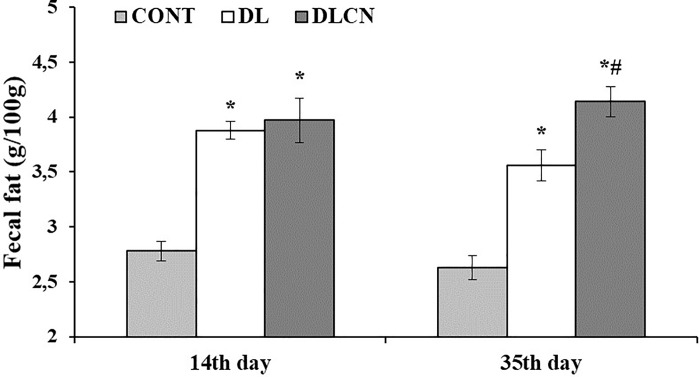
Fecal fat of rats treated with a high-fat diet with cashew nut.Rats were divided into the following groups: Control group (CONT), Dyslipidaemic group (DL) and Dyslipidemic Cashew Nut group (DLCN). The first collection occurred at 14th day of the experiment and the second collection at 35th day of experiment. * versus CONT. # versus DL, with p < 0.05, determined by One-Way ANOVA followed by the Tukey test, where values are expressed as the mean ± SEM.